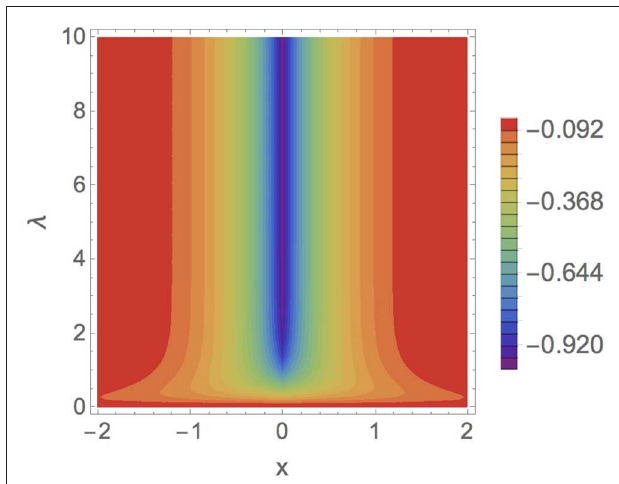
FIGURE 4 | Charge density (61) as a function of x for positrons when Q m 1 and q 0 (mass-spike δ = = =